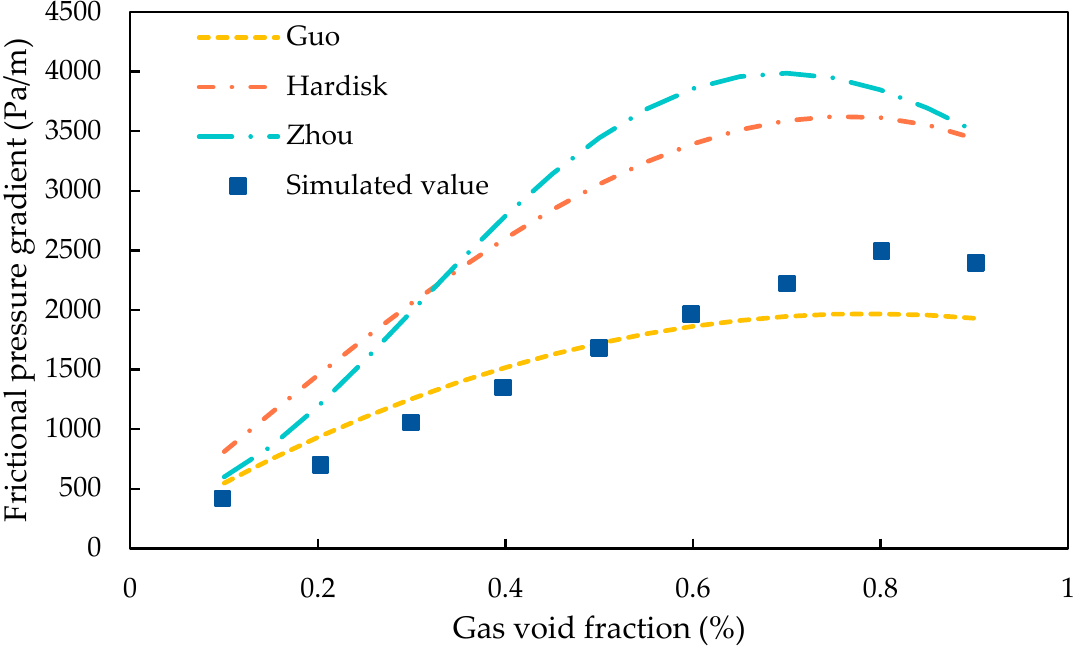
Figure 7. Comparisons between simulations and calculations of Hardik, Guo, and Zhao correlations. 3.4. Effect of Curvature Ratio on Frictional Pressure Losses The curvature ratios of M1, M2, M3 and M4 are 0.01, 0.019, 0.031 and 0.076, respectively. The gas void fraction was set to 0.2, 0.4, 0.6 and 0.8, respectively, and flow in M1, M2, M3 and M4 coiled tubing was simulated. Figure 8 shows the frictional pressure gradient with curvature ratio at four different gas void